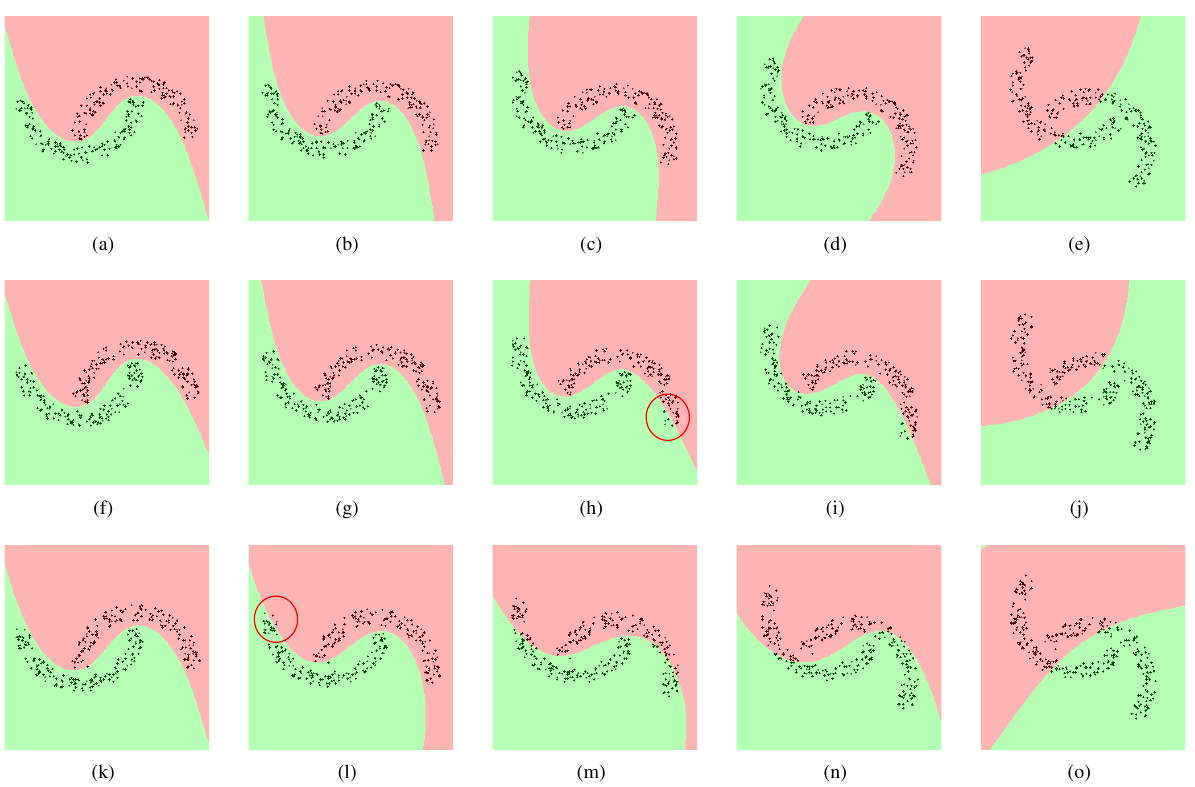
Figure 1: Synthetic test data set with different rotation and parameter (cid:18) : (a), (f), (k) source training samples and decision regions obtained for the source domain with proposed methodology. Target samples of the same data set and decision regions obtained for the target domain problem after clockwise rotation with: (b), (g), (l) ϕ = 10 ◦ , (c), (h), (m) ϕ = 20 ◦ , (d), (i), (n) ϕ = 30 ◦ , (e), (j), (o) ϕ = 40 ◦ . The parameter (cid:18) is set to: (cid:18) = 0 : 877 in (a)-(e), (cid:18) = 0 : 0 in (f)-(j), (cid:18) = 1 : 0 in (k)-(o). The red circles highlight target domain samples assigned to the wrong class in the transfer process for (cid:18) = 0 : 0 and (cid:18) = 1 : 0 . Note that the class labels of the target samples used for training the final classifier were only determined based on logistic